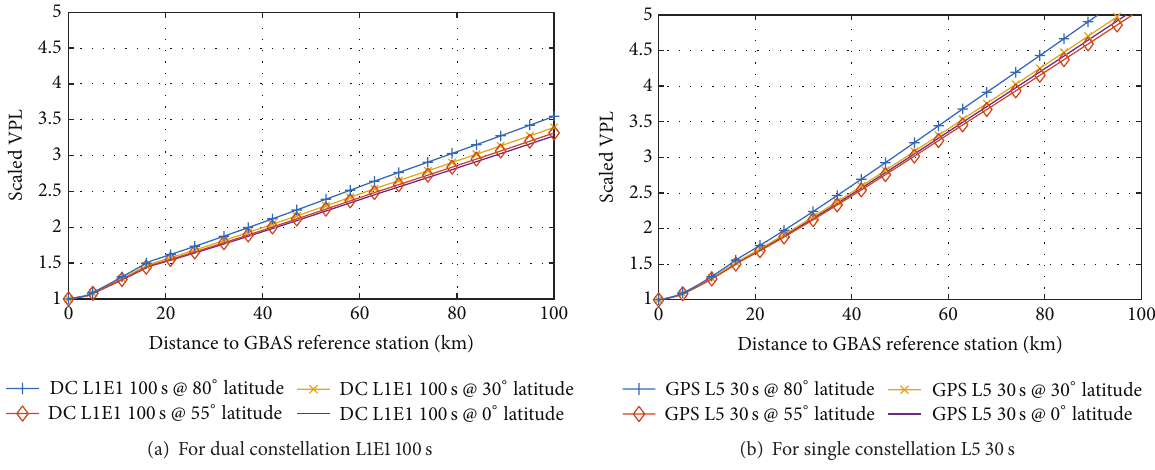
Figure 10: H0 VPL behavior at different latitudes, normalized by VPL at zero distance to the